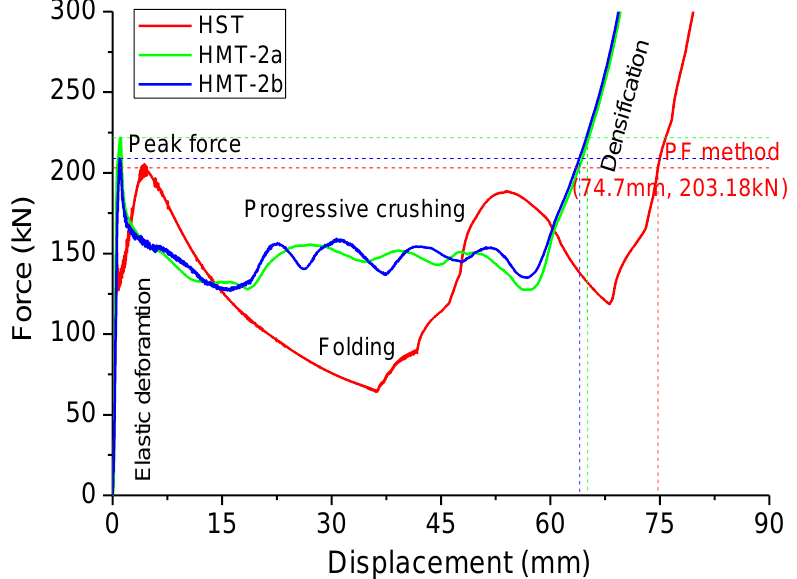
Figure 5. Force – displacement curves of compressed hexagonal HST and HMTs. Figure 5. Force–displacement curves of compressed hexagonal HST and HMTs.